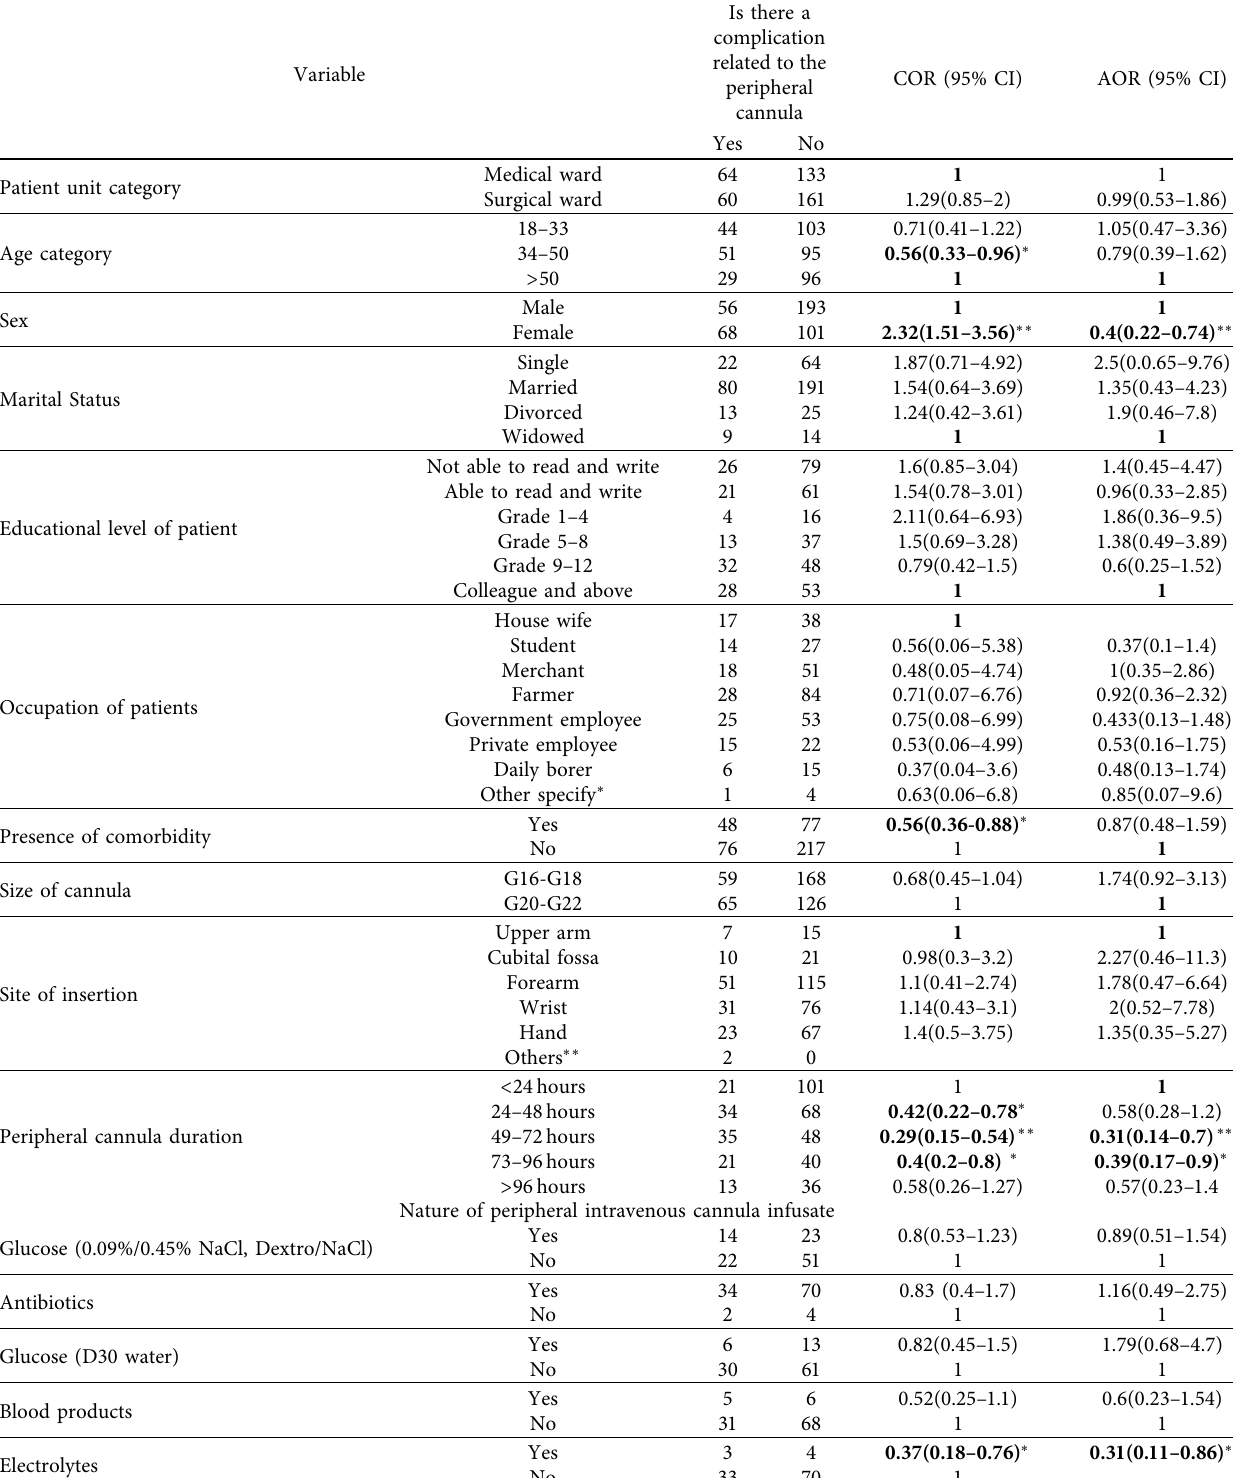
Table 4: Factors associated with the incidence of failed first intravenous catheter among adult inpatients at medical-surgical wards in Public Referral Hospitals of West Amhara Regional State, Ethiopia, 2021 ( N �